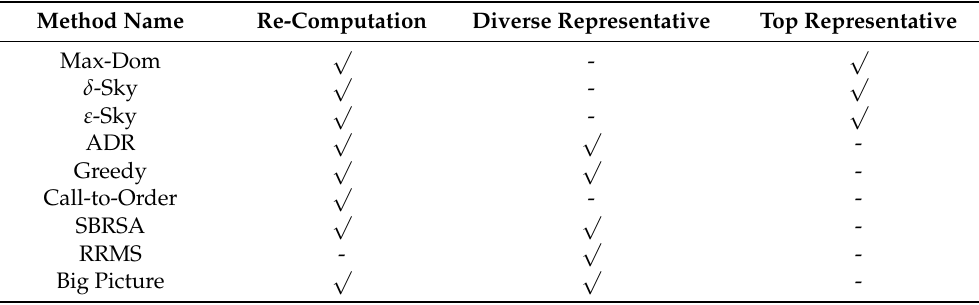
Table 1. Analysis of current representative skyline query processing